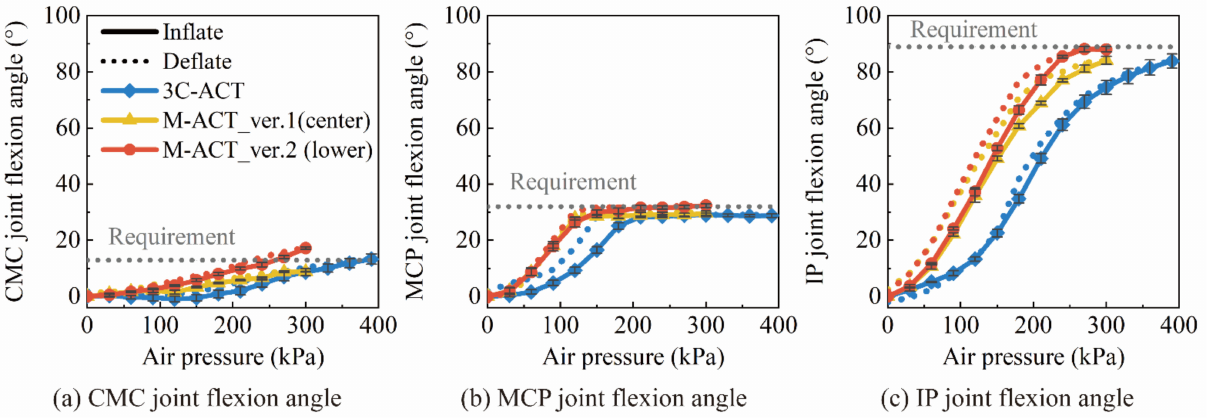
Figure 3. Flexion RoM. CMC: carpometacarpal; MCP: metacarpophalangeal; IP: